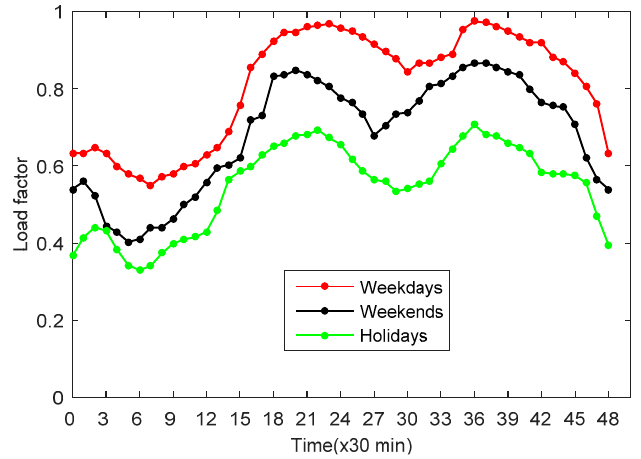
Figure 7. The typical timing characteristic curves of load fluctuation for the spring.